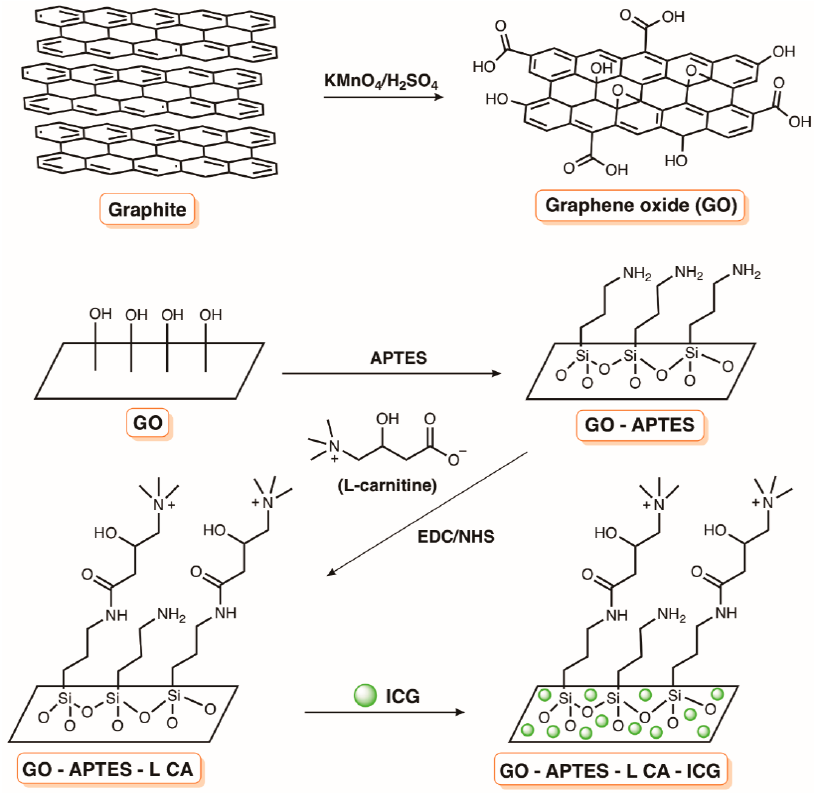
Figure 35. Functionalization of GO with APTS and L CA and incorporation of ICG (adapted from Reference [189]).